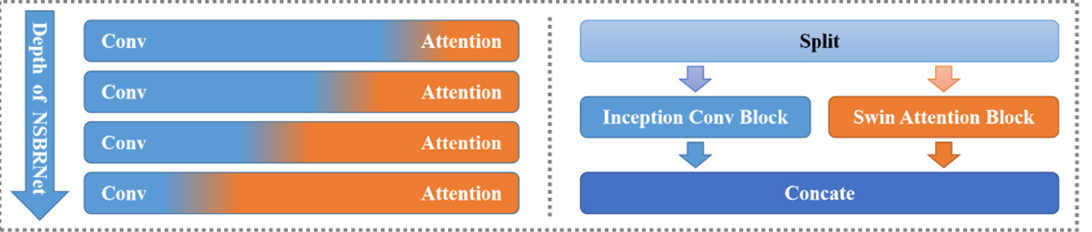
Figure 8. Structure of hybrid feature extraction.